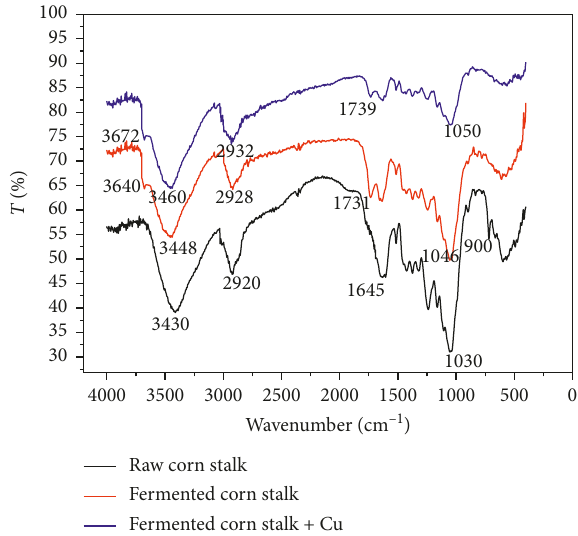
Figure 7: FTIR spectra of modified corn stalk and raw corn